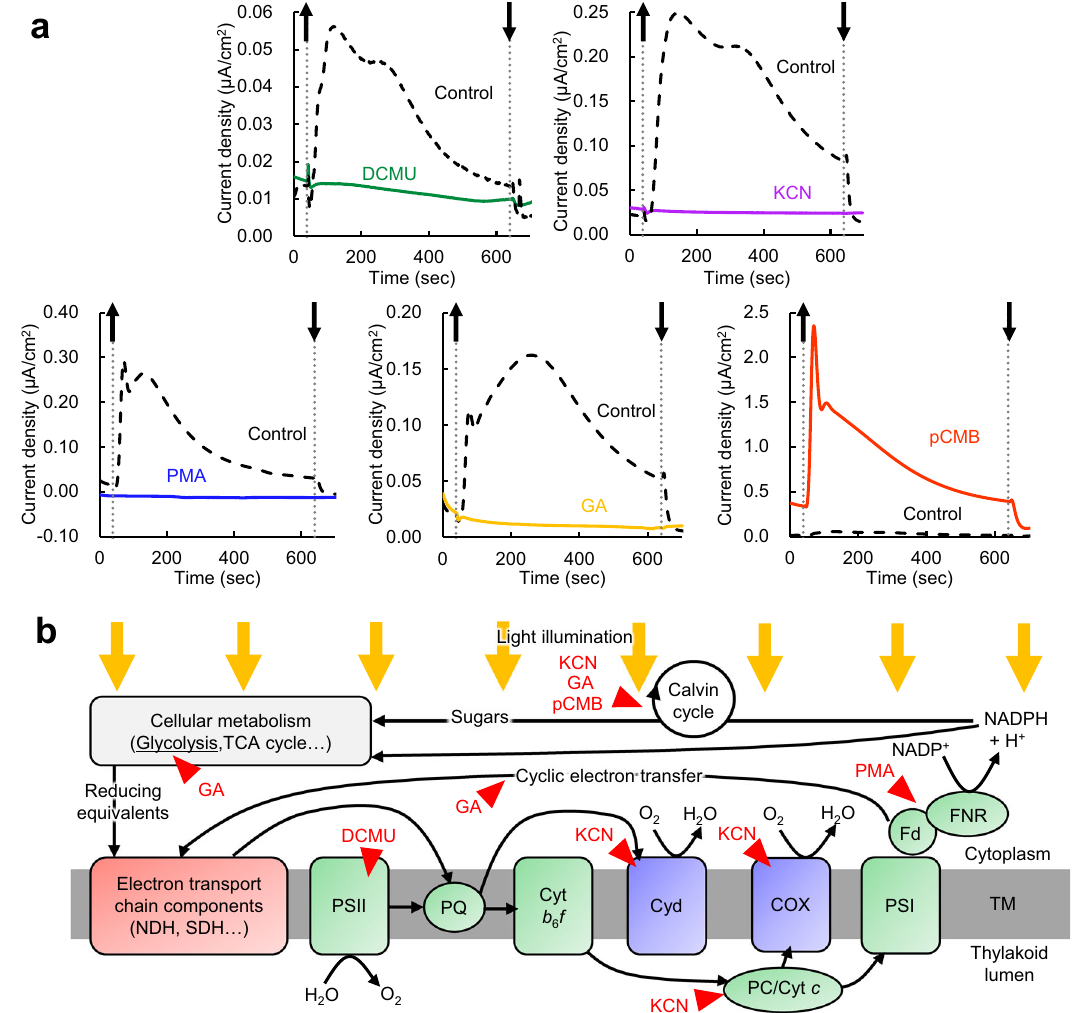
Fig. 2 Effects of photosynthesis inhibitors on current generation from slr0688i. a Representative chronoamperograms at + 0.25 V vs Ag/AgCl with fl at ITO anodes of slr0688i treated with 10 µ M DCMU (green line), 5 mM KCN (violet line), 50 µ M PMA (blue line), 10 mM GA (yellow line), and 100 µ M pCMB (red line) are shown with respective controls (black dashed line). The upward and downward arrows indicate the beginning and end of illumination (70 µ mol photons m − 2 s − 1 ), respectively. b Target sites of the tested inhibitors. Red triangles show the target sites of the tested inhibitors. The photosynthetic chain of Synechocystis cells shares some components with the respiratory chain 86 – 88 . TM, thylakoid membranes; NDH, NAD(P)H dehydrogenase; SDH, succinate dehydrogenase; Cyd, cytochrome bd – quinol oxidase complex; COX, aa 3 -type cytochrome c oxidase; PC, plastocyanin; Cyt c , cytochrome c . Source data are provided as a Source Data fi